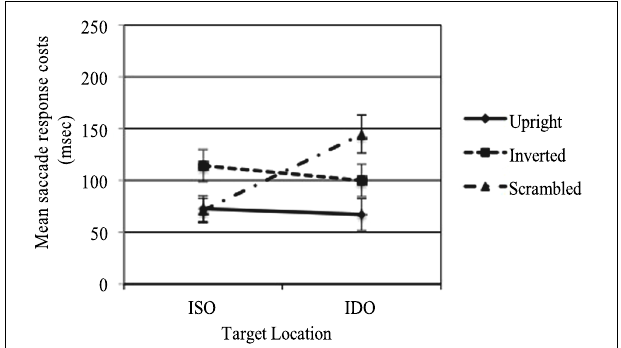
FIGURE 4 |Adults’ means saccade response costs from invalid cueing trials (given by invalid-cue latencies minus valid-cue latencies) related to the two invalid conditions (i.e., whether the stimuli that contained the target was cued or uncued) and the three types of stimuli presented (upright, inverted, and scrambled